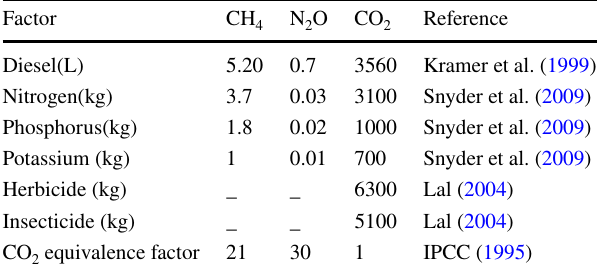
Table 2 Gaseous emissions (g) per unit of input